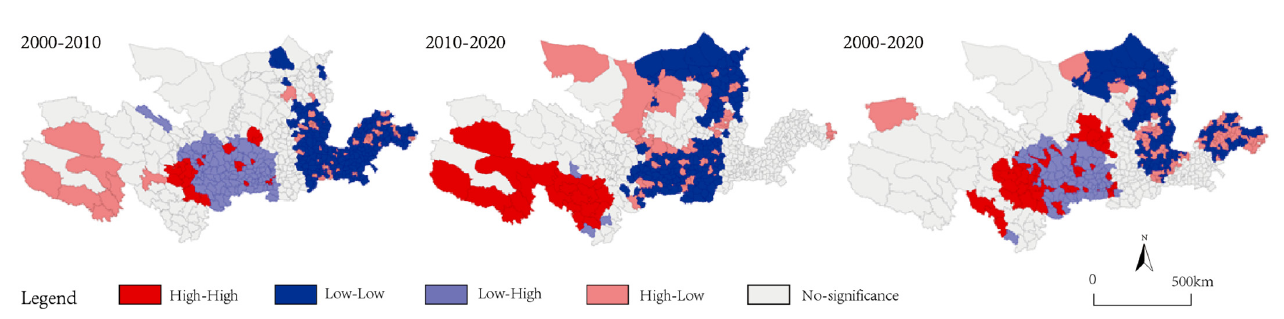
Figure 4. Local space – time bivariate spatial autocorrelation from 2000 to 2020. Table 4. Bivariate shrinkage pattern recognition.